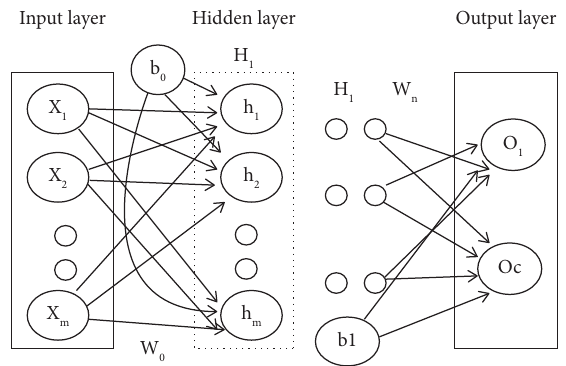
Figure 6: Construction of a deep neural network